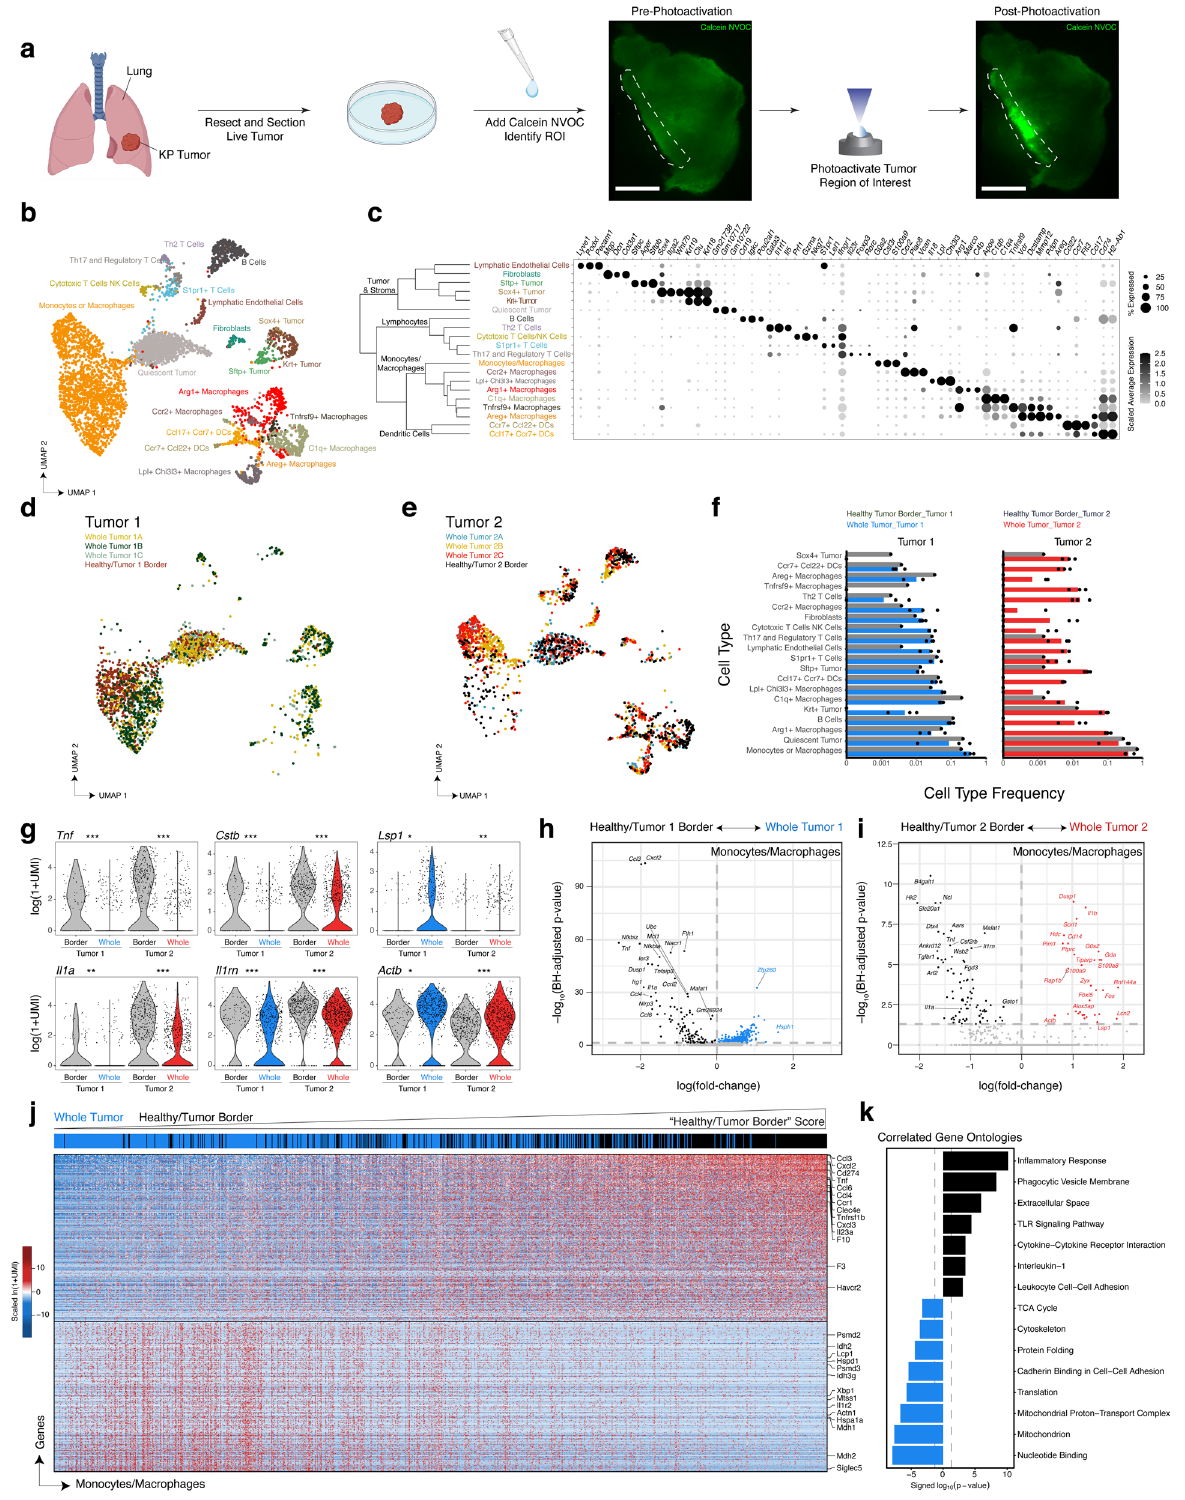
Gene ontology enrichment revealed the cellular pathways associated with this ranking inclusive of several enrichments of potential relevance to the spatial organization of the tumor microenvironment (Fig. 4k and Supplementary Data 4). While this study is underpowered to make de fi nite conclusions